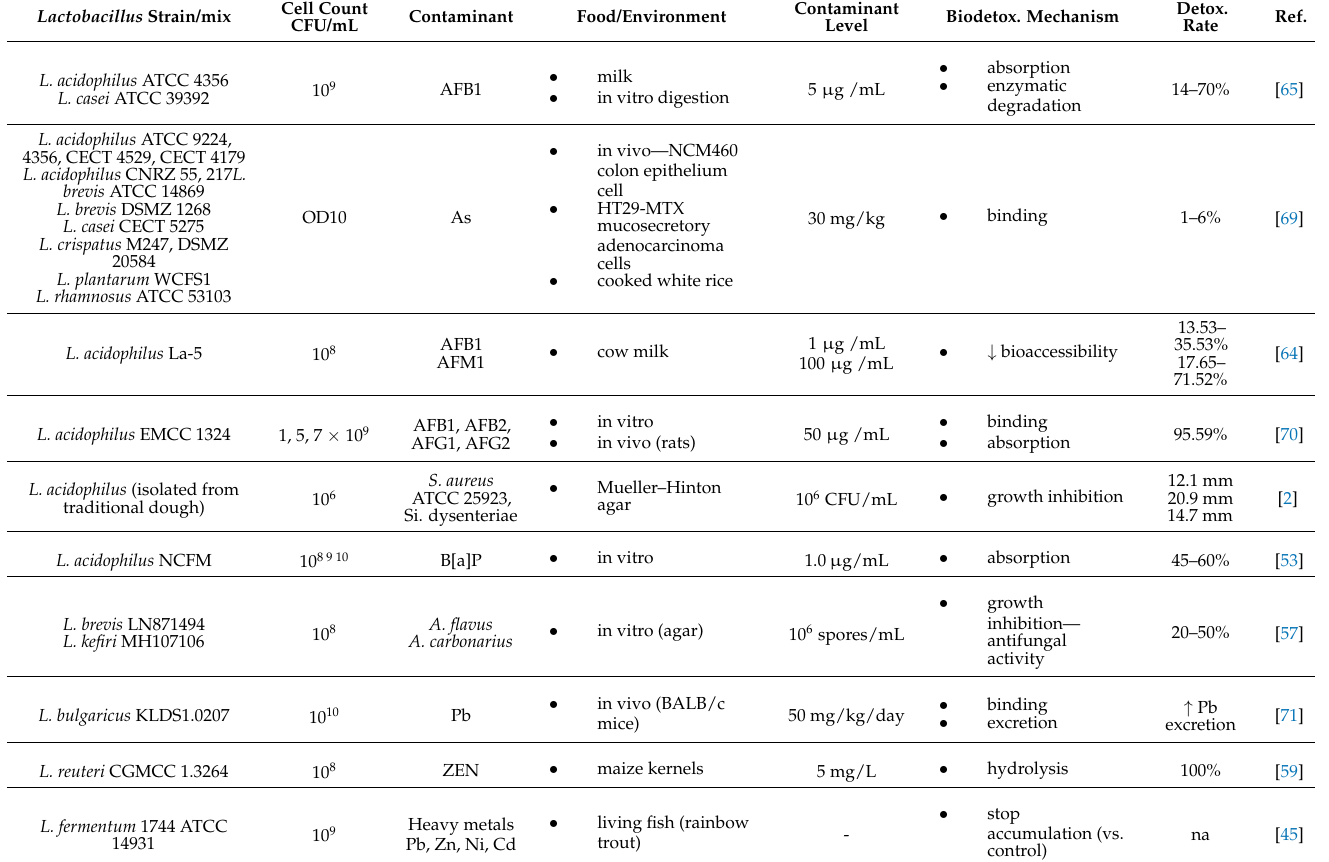
Table 1. Lactobacillus strains, their biodetoxification mechanisms, and rates for different food contaminants. Lactobacillus Strain/mix Cell Count CFU/mL Contaminant Food/Environment Contaminant Level Biodetox. Mechanism Detox. Rate